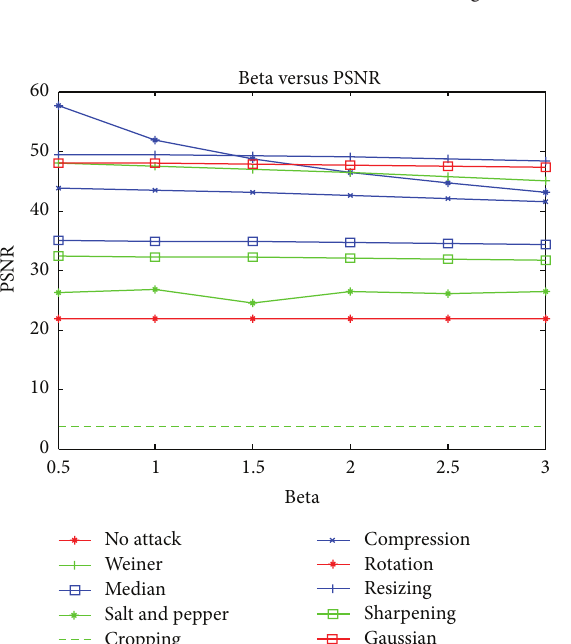
Figure 5: Watermarked image: (a) mdb001, (b) mdb017, (c) mdb054, and (d) mdb153.